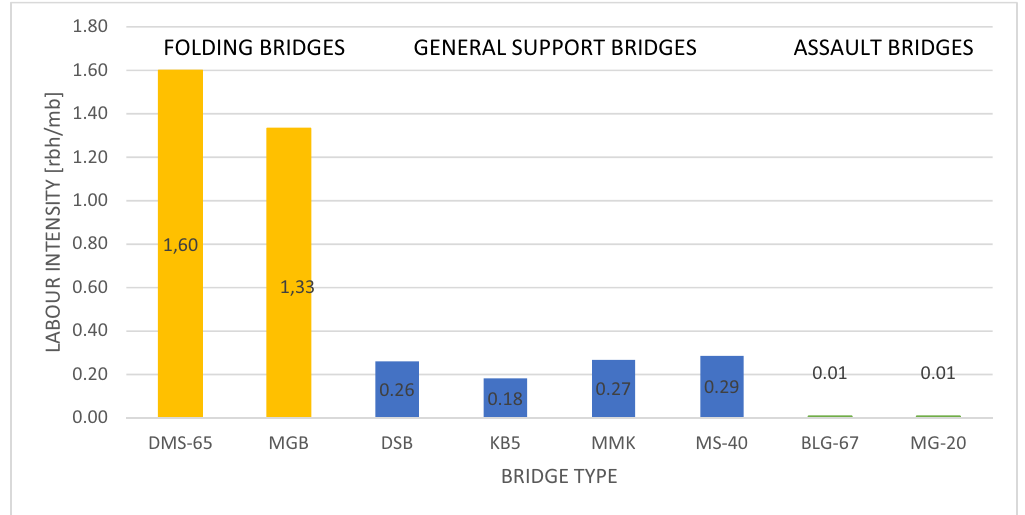
Figure 6: Comparison of the labour intensity of di ff erent bridging